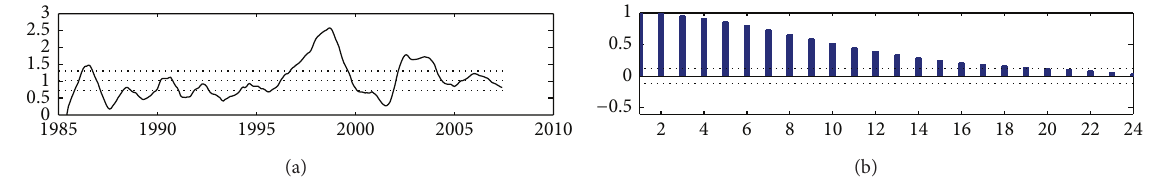
Figure 3: (a) Relative (sqrt) incidence of American Tegumentary Leishmaniasis cases in Or´an, Salta, Argentina, period 1985–2007. (b) Sample autocorrelation function for relative (sqrt) incidence of American Tegumentary Leishmaniasis in Department of Or´an, 1985–2007.